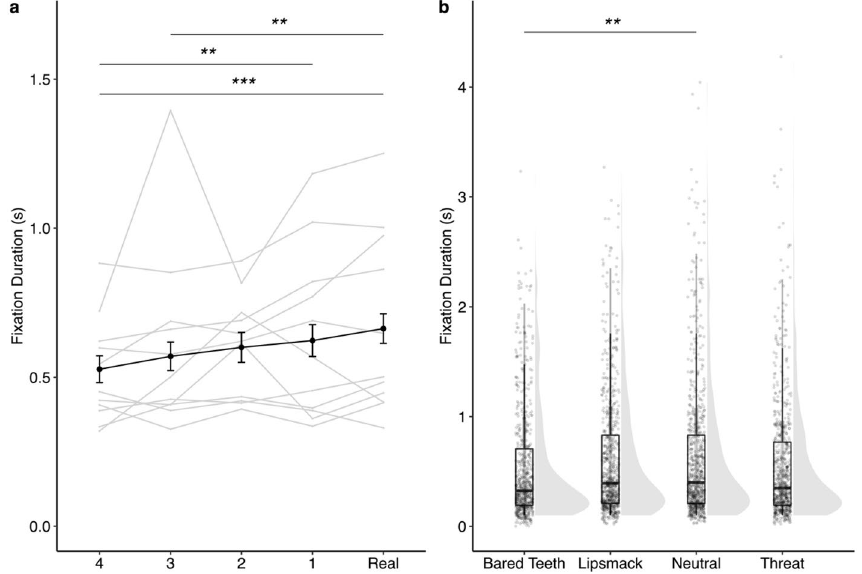
Figure 4. Duration of fixations directed at the eyes of the face stimuli. ( a ) Gray lines represent average fixation duration of a given subject across all facial behaviors. The black line represents average fixation duration across all subjects. Data in this panel represent 514–573 individual trials per Face Realness level. Subjects looked longer at the eyes in the Real image compared to either the least realistic Face 4 ( z = 4.31, p < 0.001) or Face 3 ( z = 3.51, p = 0.004). Subjects also looked longer at the eyes in the most realistic manipulated Face 1 image compared to the least realistic Face 4 image ( z = 3.41, p = 0.005), which contradicts what would be expected for a UV in which Face 1 is anticipated to receive the least amount of attention. ( b ) Plots represent individual data points (622–722 trials per facial behavior) overlaid on boxplots on the left with violin plot density functions on the right for each facial behavior. Monkeys altered how long they looked at the eyes based on facial behavior of the stimulus, such that monkeys spent less time looking at the eyes of a face with the bared teeth display than one displaying a neutral facial behavior ( z = 2.40, p = 0.004). * p < 0.05, ** p < 0.01, *** p < 0.001. Error bars represent mean ± 95% confidence